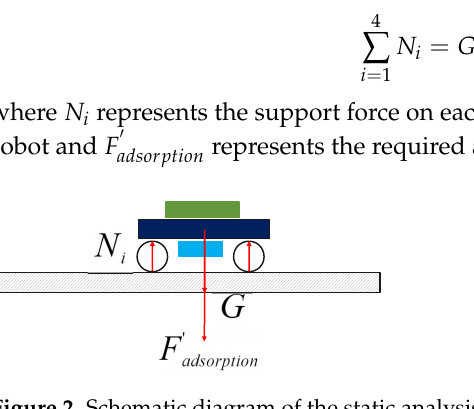
Figure 2. Schematic diagram of the static analysis under State